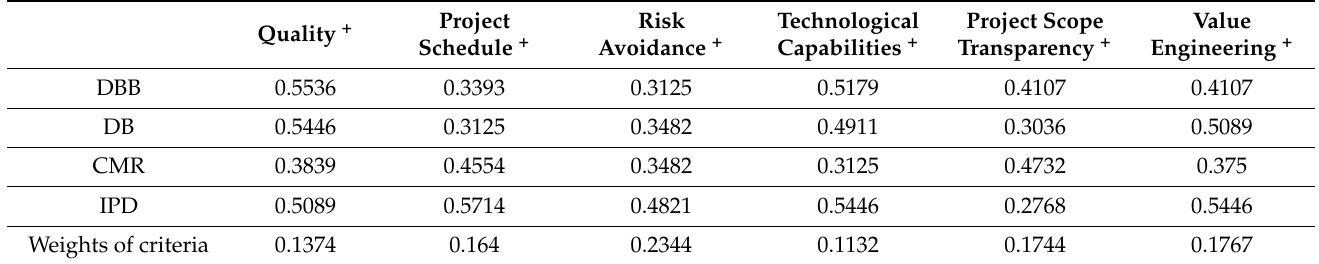
Table 7. Decision matrix.